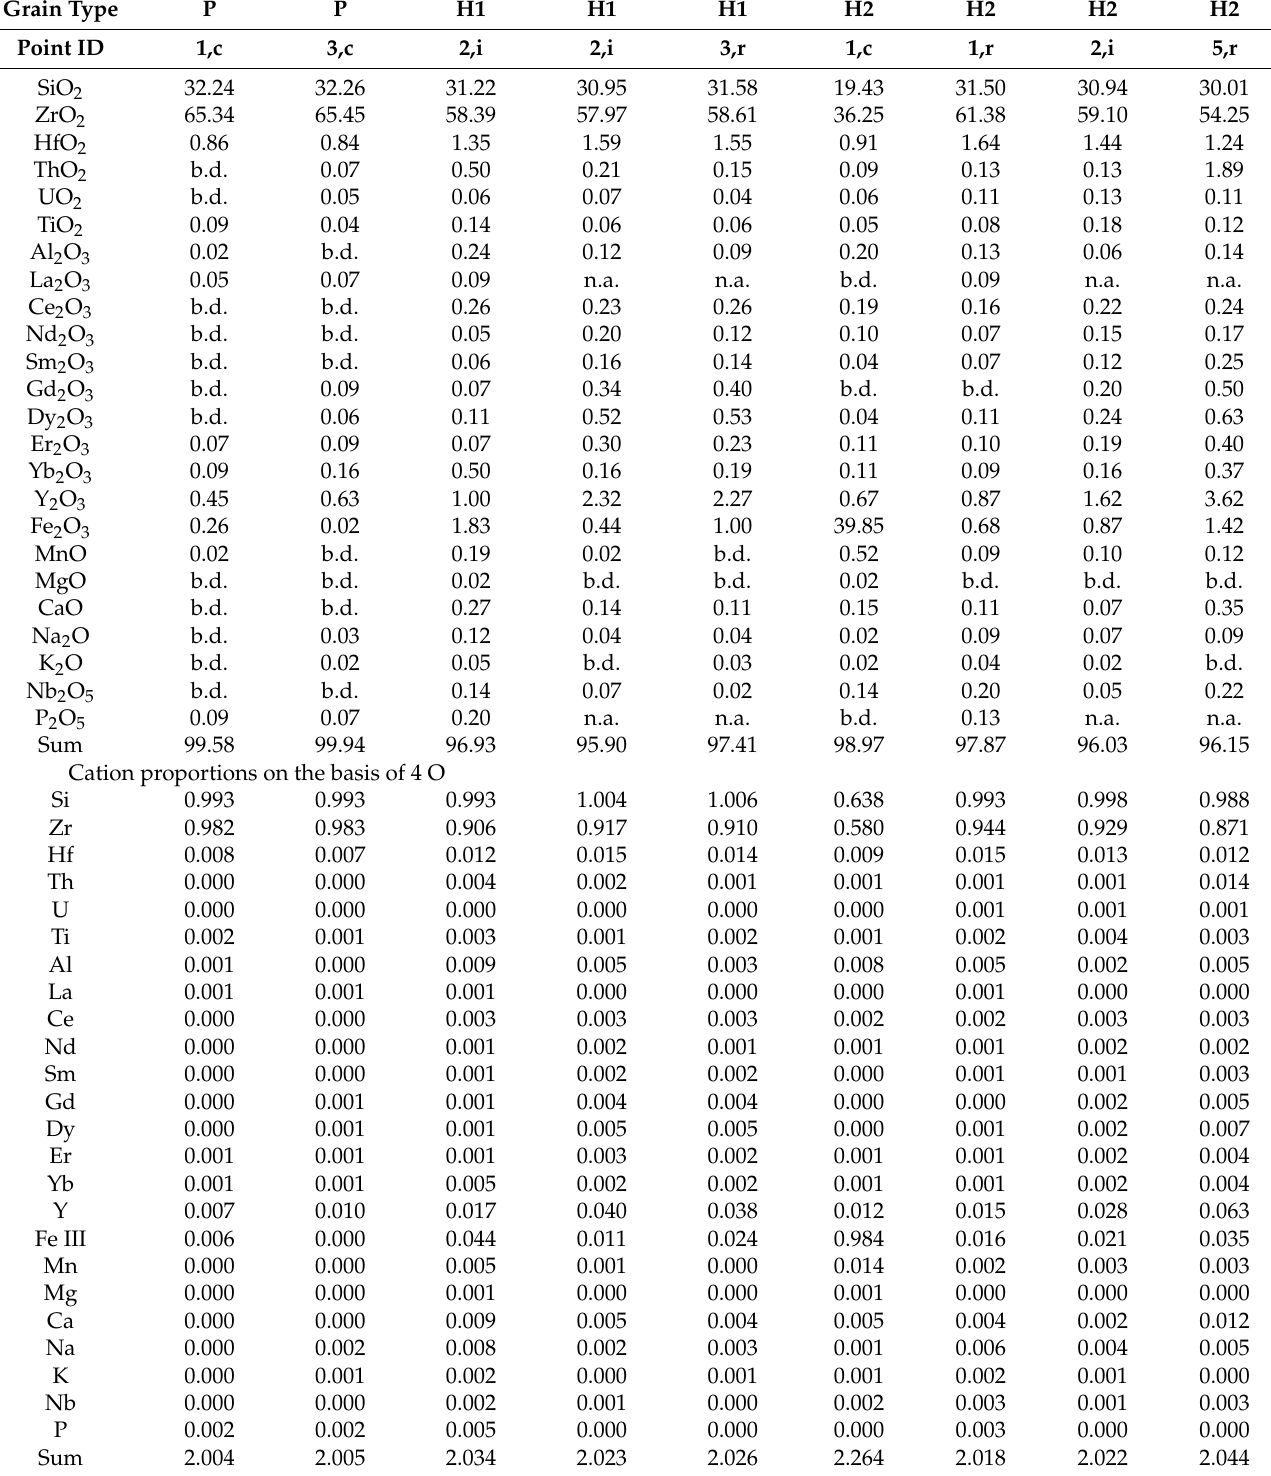
Table 1. Representative chemical compositions (wt.%, WDS) and cation proportions for primary (P) and hydrothermal (H) zircon crystals and aggregates, respectively. WDS spot locations for points 1,c and 3,c as given in Figure 4a,c, respectively. H1 = botryoidal aggregates and transparent overgrowth (r); H2 = lenticular fibro-radiated (1,c and 1,r from Figure 3e) and spherulitic fibro-radiated crypto- and micro-crystalline varieties. c = core; I = intermediate zone; r = rim; n.a. = not analyzed; b.d. = below detection limit. All Fe computed as Fe 2 O 3